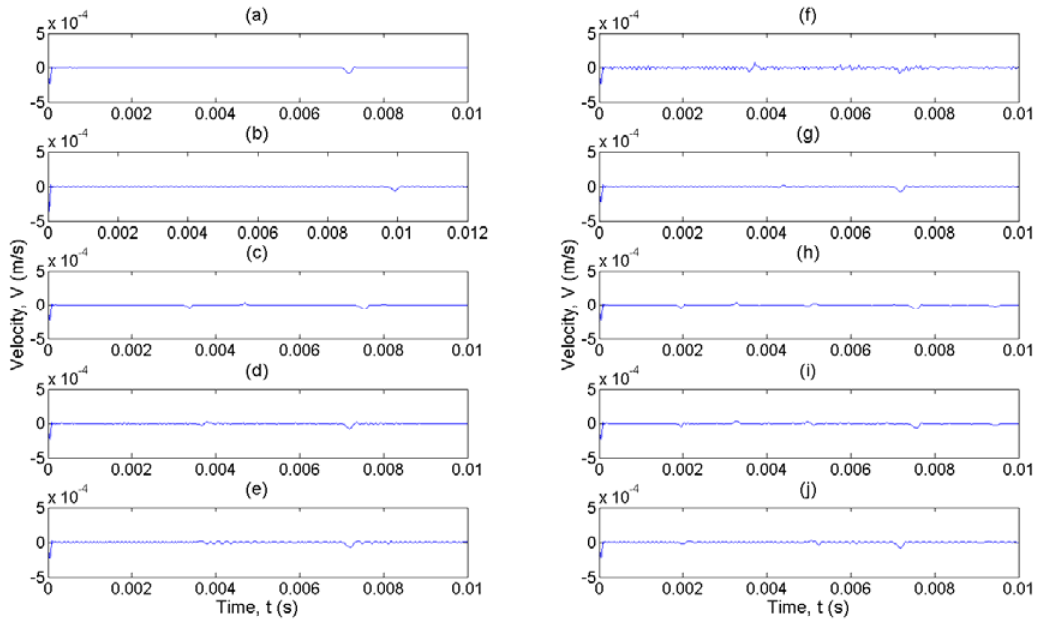
Figure 9. Velocity records of wave reflection responses for the simulated pile cases ( a ‐ j ) shown in Figure 8.